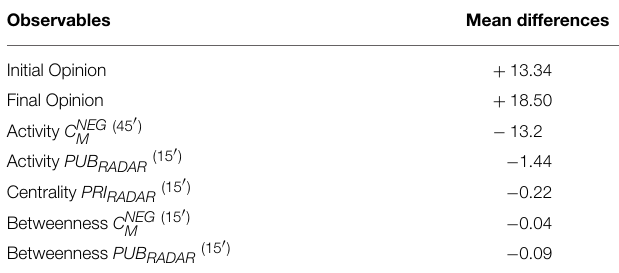
TABLE 10 | Mean differences characterizing the Stubborn